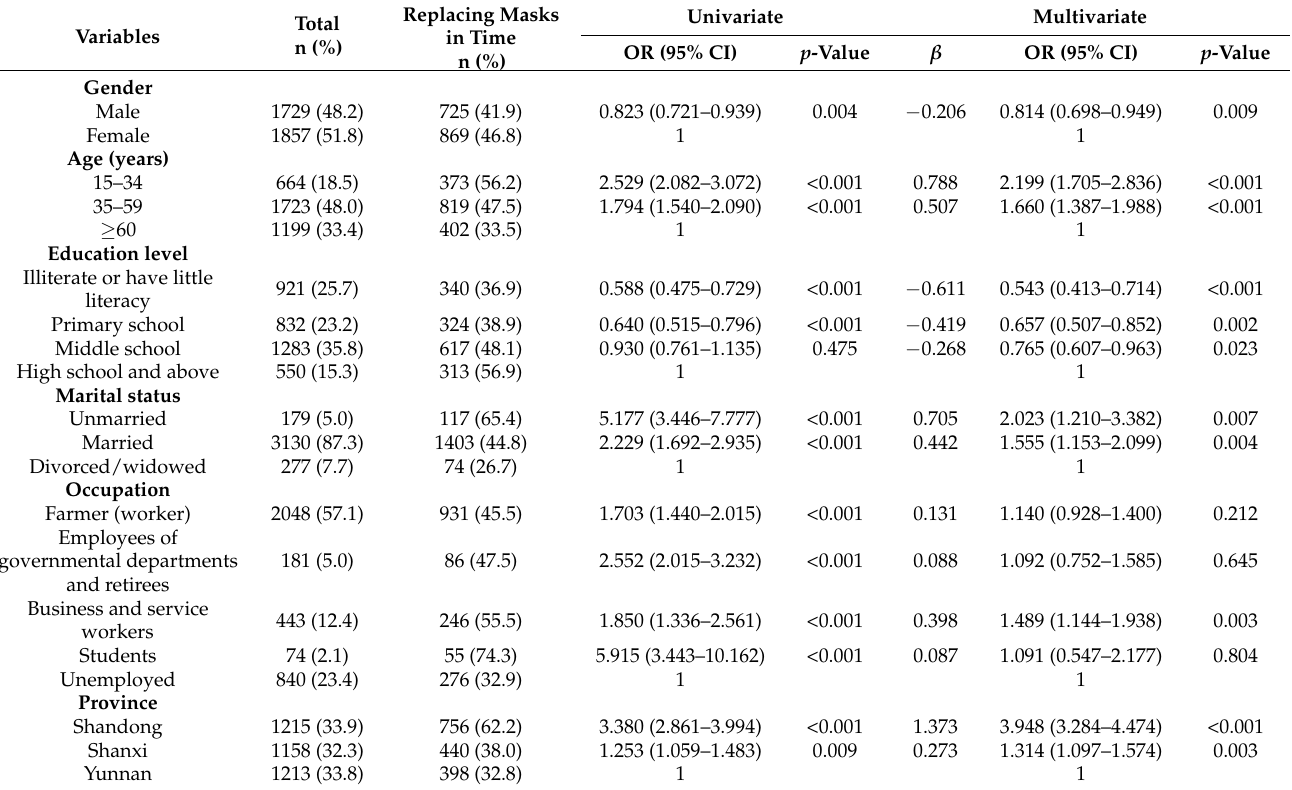
Table 4. Logistic regression analysis for influencing factors on mask replacement (n =